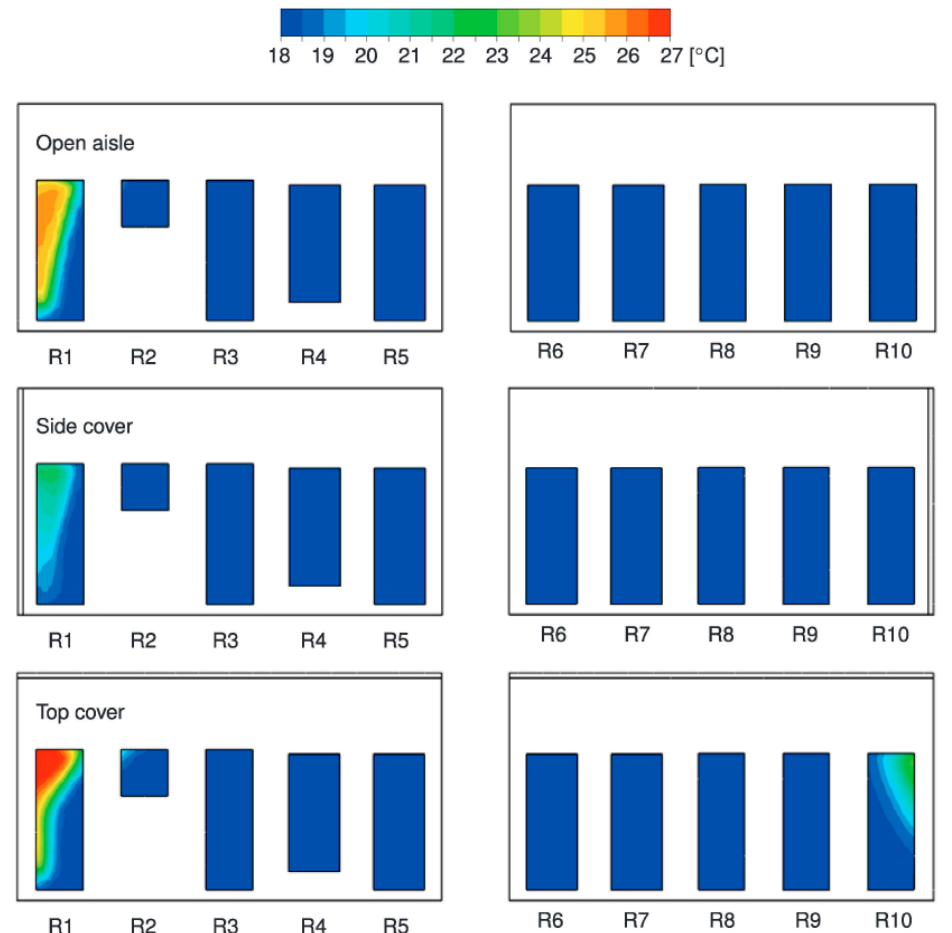
Figure 7. Rack intake temperatures for the hard floor configurations.